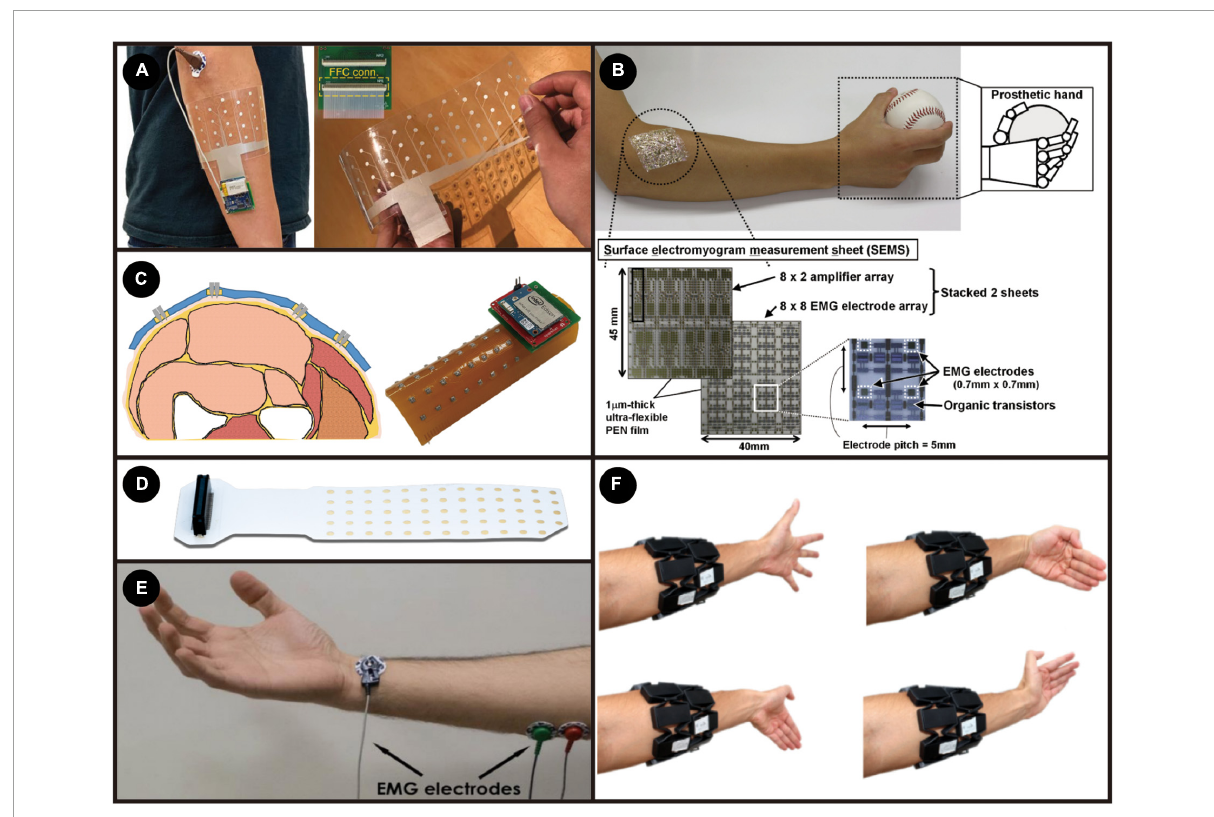
FIGURE7 (A) The sEMG electrode array and its experiment setup. Adapted from Moin et al. (2021). Copyright 2021, Nature; (B) ultra-flexible high-density EMG measurement sheet. Adapted from Fuketa et al. (2014). Copyright 2014, IEEE; (C) Microneedle-Based High-Density Electrode Array. Reproduced with permission (Kim et al., 2018). Copyright 2018, Sensors; (D) adhesive EMG electrode matrices (GR08MM1305, OT Bioelettronica). (E) Bipolar electrode recording setup. Reproduced with permission (Esposito et al., 2018). Copyright 2018, Sensors; (F) gesture classification using MyoBand. Reproduced with permission (Simão et al., 2019). Copyright 2019,